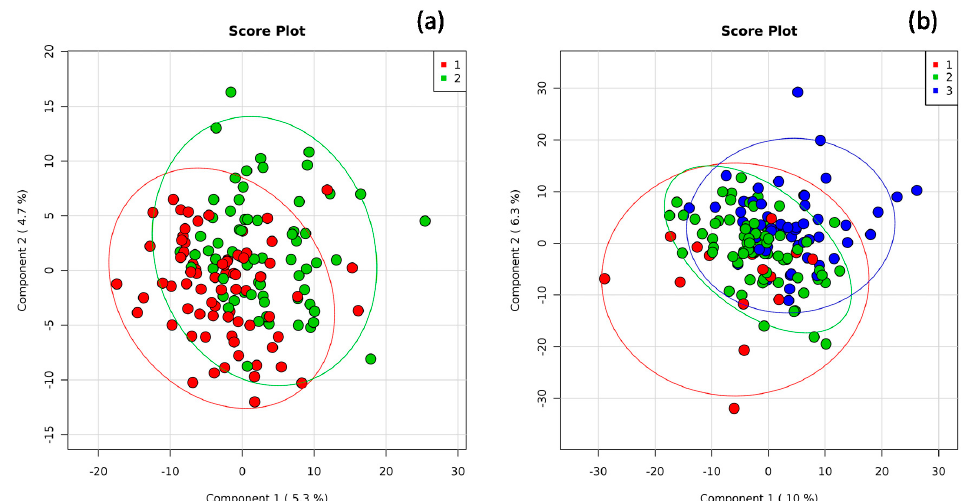
Figure 3. Principal coordinates analysis (PCoA) of the weighted Bray–Curtis for 16S rDNA data related to ( a ) the Mediterranean diet (MD) score: 1: low adherence (score ranging from 0 to 5) and 2: higher adherence to MD (score > 5) and ( b ) habitual physical activity (PA) level: 1: low, 2: moderate, and 3: high. Percentages on the axes represent the proportion of the variation explained by the 2 first components of the PCoA. Table 3. Comparisons of the Shannon Index, Firmicutes , Bacteroidetes , and F / B ratio of the subgroups categorized on the basis of MD adherence and PA levels, with corresponding p